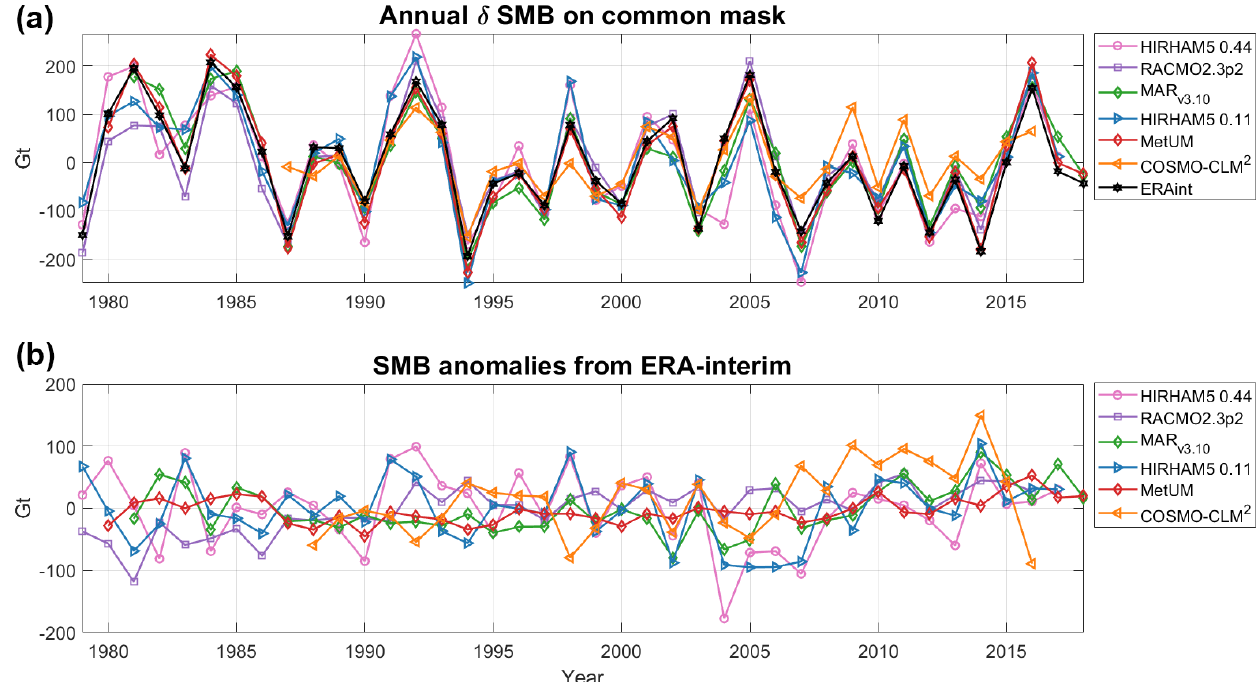
Figure 8. Panel (a) shows the annual variability in surface mass balance over the common mask for each of the different RCMs in the period 1979–2018. It is calculated by subtracting the respective model mean from each RCM’s SMB time series. Panel (b) displays how modelled SMB from each RCM deviates from the ERA-Interim SMB.